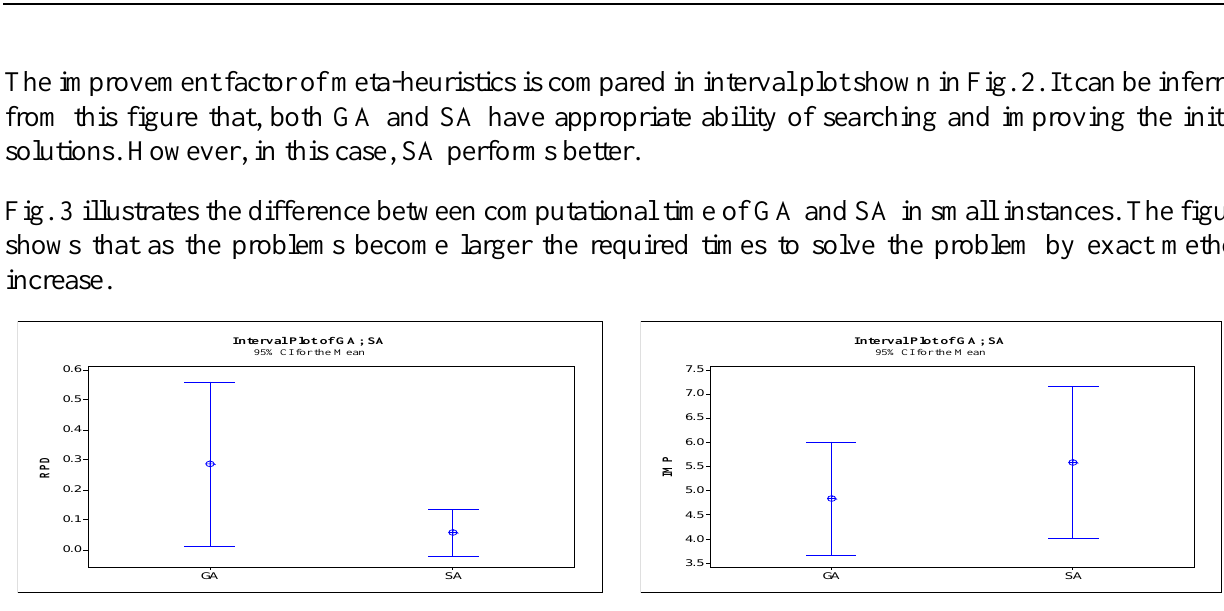
Fig. 2. Mean and interval plot for the RPD of GA and SA